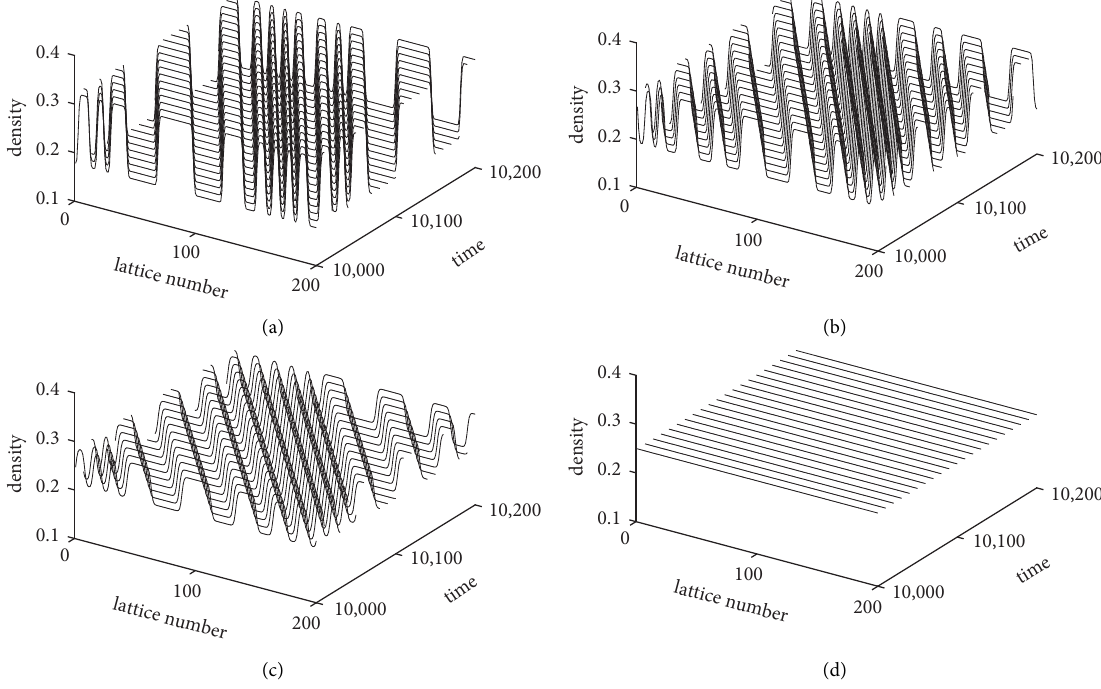
Figure 6: The evolution of the traffic densities for different values of parameter p : (a) p � 0; (b) p � 0 . 05; (c) p � 0 . 1; (d) p � 0 . 15.